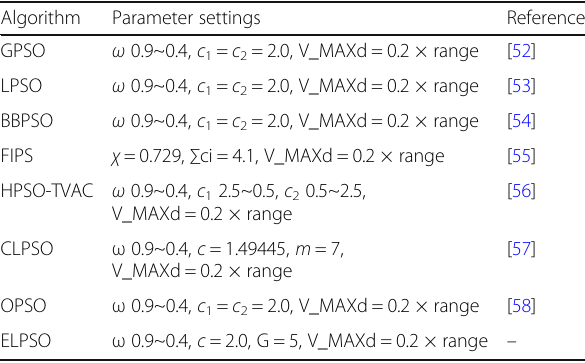
Table 1 PSOs compared Algorithm Parameter settings Reference